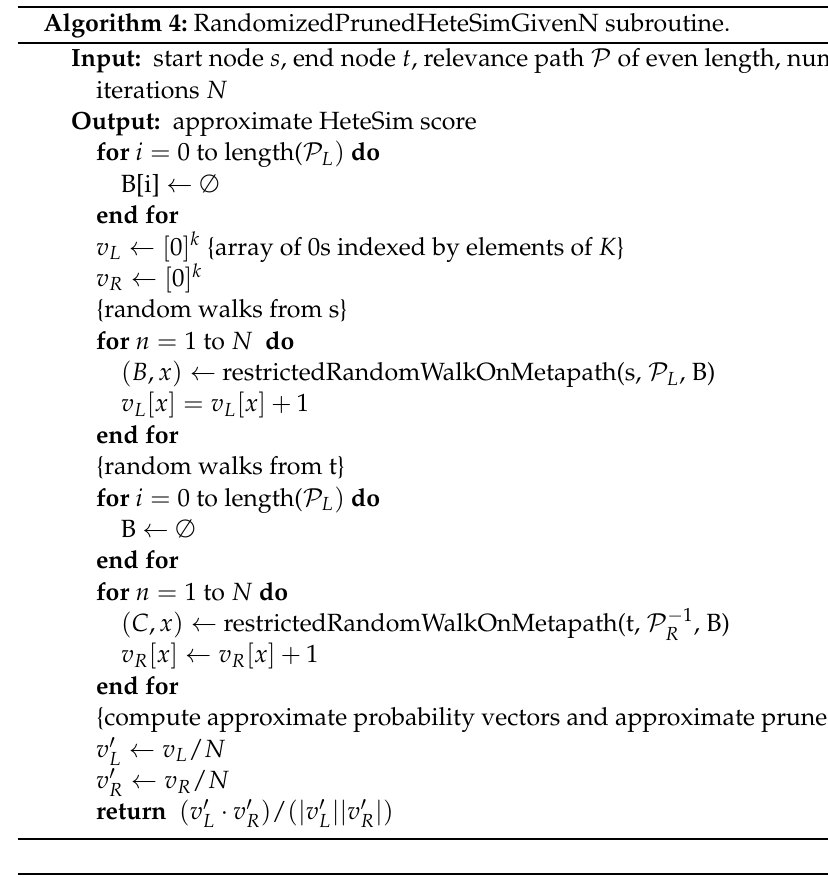
Algorithm 5: restrictedRandomWalkOnMetapath